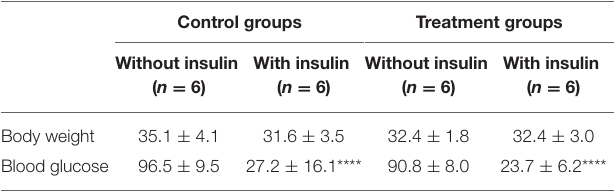
TABLE 1 | Body weight (g) and blood glucose concentration (mg/dl) in brain 18 F-FDG autoradiography study.